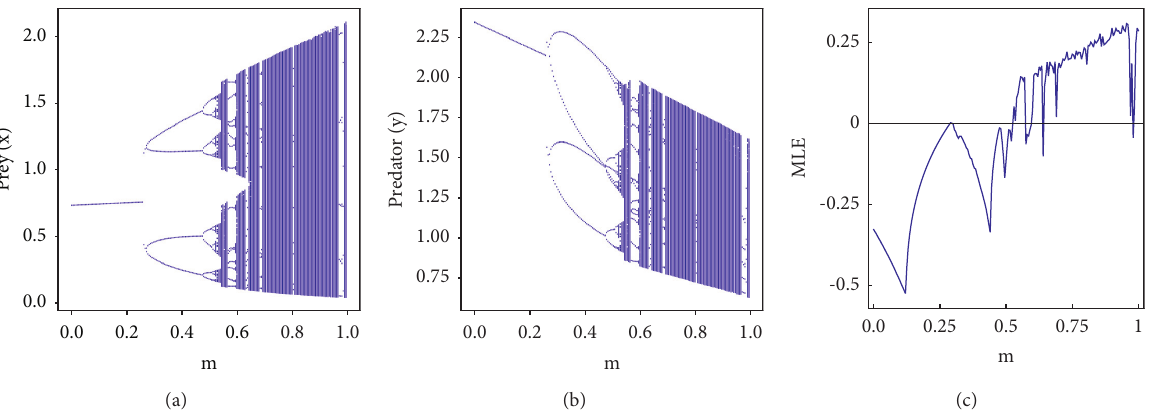
Figure 3: ((a), (b)). The flip bifurcation diagrams. (c) The maximum Lyapunov exponents for system (5) with r � 1, h � 0 . 525, c � 0 . 5, and m ∈ [ 0 , 1 ] b � 2 . 5, r 2